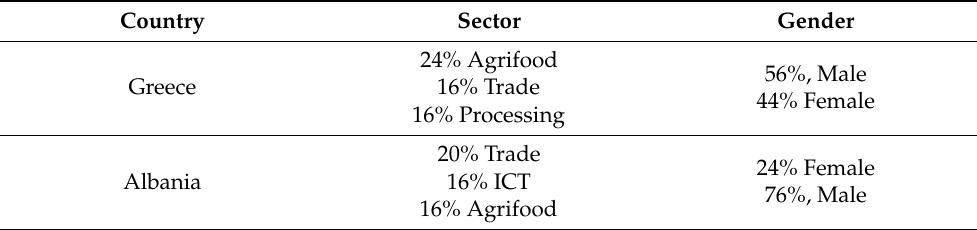
Table 1. Sector of operation of surveyed companies, and gender. Country Sector Gender